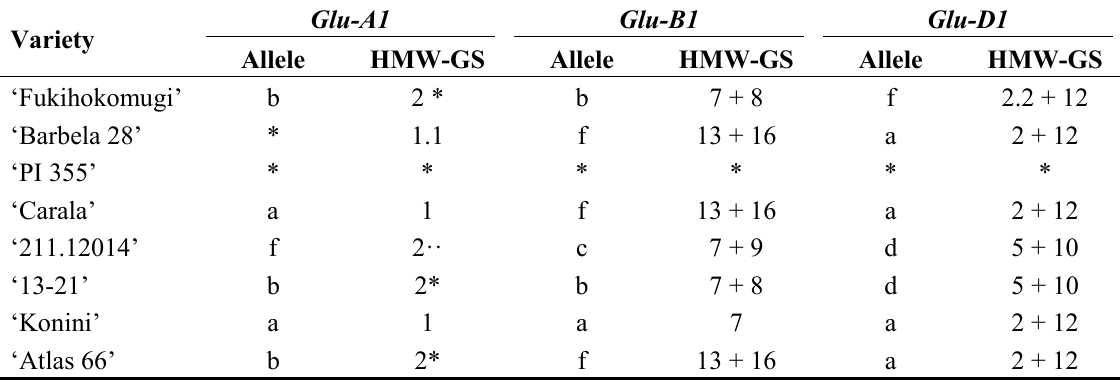
Table 3. List of wheat varieties used in this study with their respective Glu-1 alleles encoding the